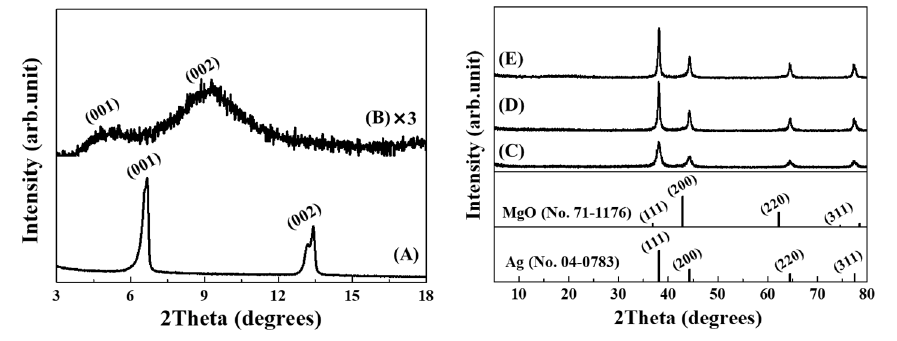
Figure 1. Powder X-ray diffraction (PXRD) patterns of ( A ) Ag/3-MPA, ( B ) Ag@LDH, ( C ) Ag@LDO400, ( D ) Ag@LDO500, and ( E ) Ag@LDO600.